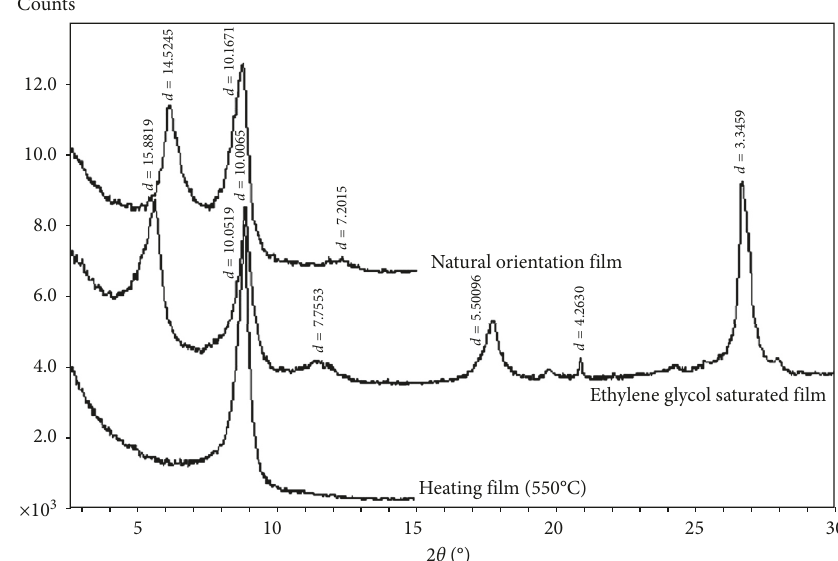
Figure 7: X-ray diffraction pattern of red clay in Tiyu west road station. Table 2: XRD results of the remaining samples.